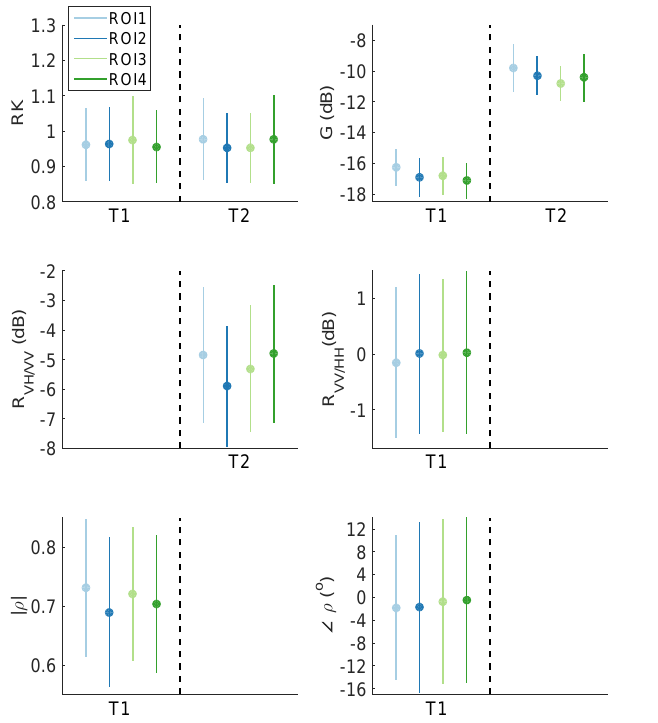
Figure 7. Mean values of the features in the regions of interest in the two TerraSAR-X scenes (T1 and T2). The error bars are 2 standard deviations long.